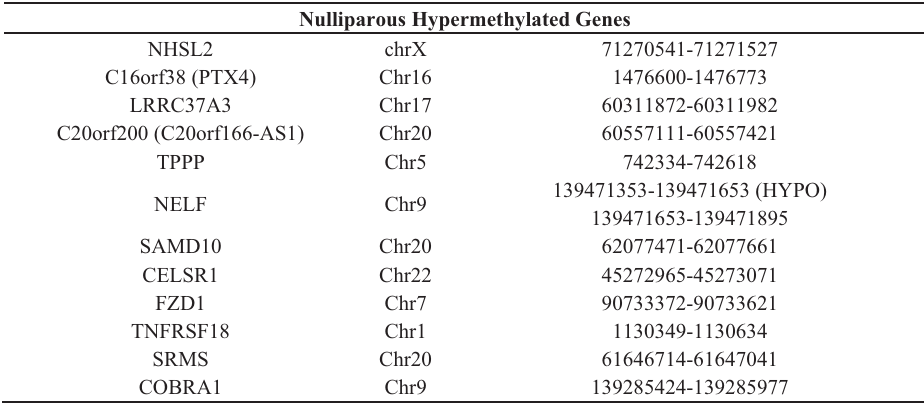
Table 3. DMRs within nulliparous hypermethylated